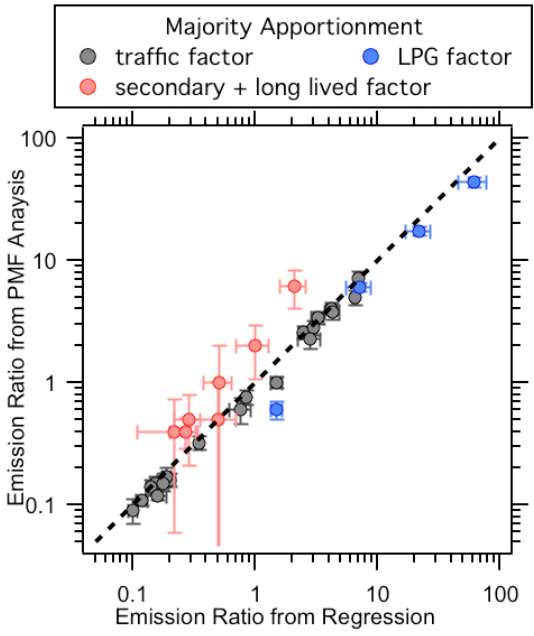
Figure 13. Comparison of PMF emission ratio estimates obtained by linear regression for all 1054 Fig. 13. Comparison of PMF emission ratio estimates obtained by measured compounds. Each point represents one compound while colors represent the dominant 1055 linear regression for all measured compounds. Each point repre- sents one compound while colors represent the dominant PMF ap- PMF apportionment for the respective measurement. 1056 portionment for the respective